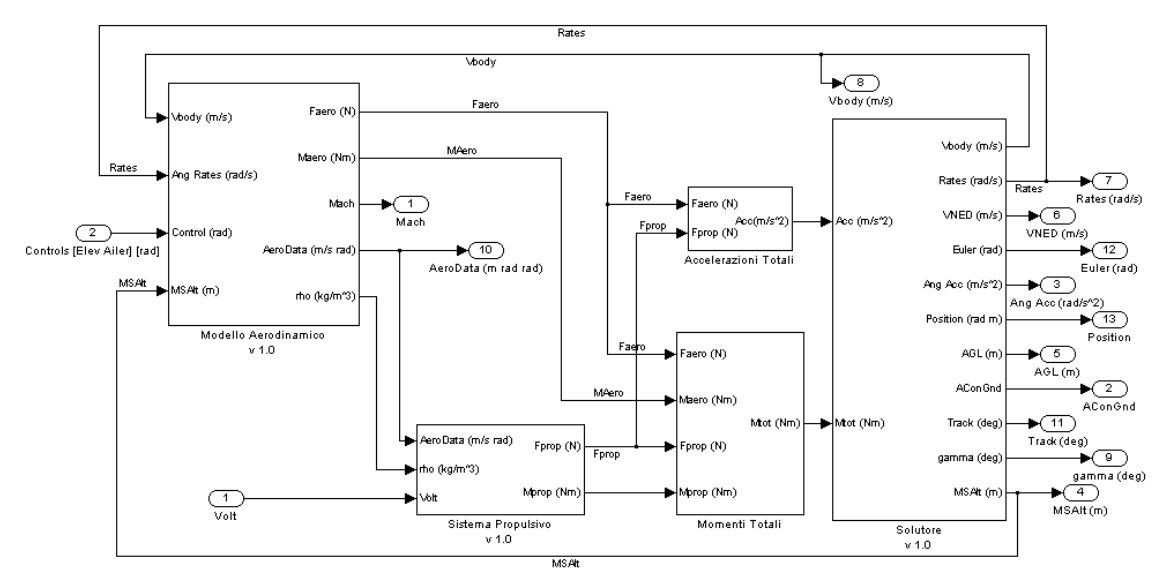
Fig 6. Mini-UAV Simulink